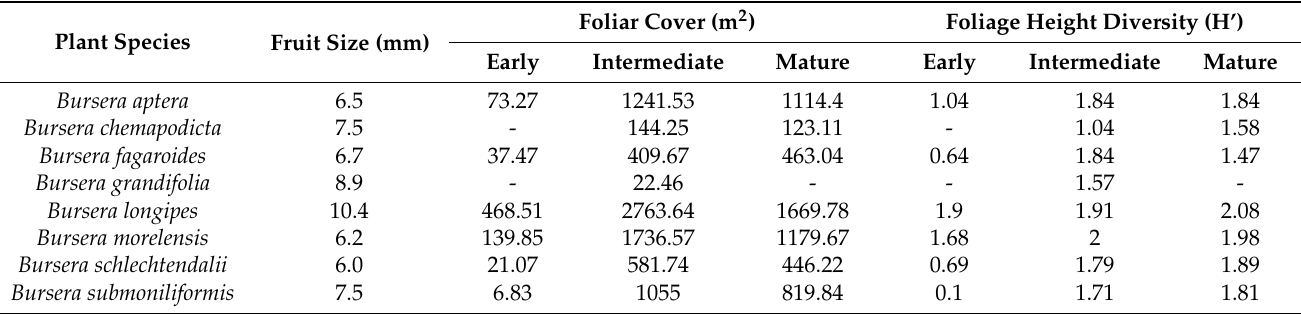
Table 1. Values of foliar cover, foliage height diversity, and fruit size of zoochorous trees along the successional gradient of TDF in southern Mexico. The cells with a hyphen mean that the tree species were not present in successional stages. Plant